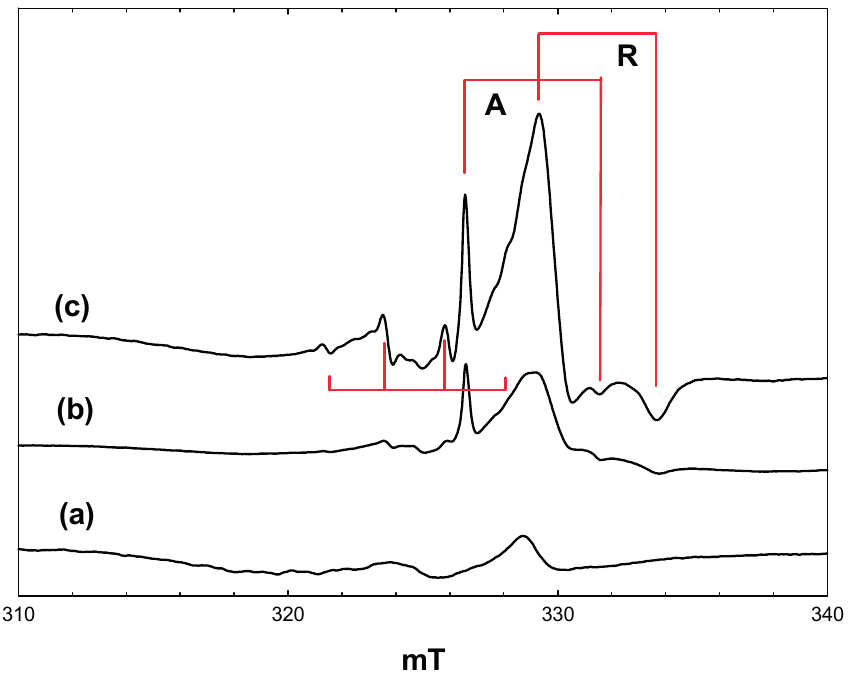
Figure 1. EPR spectra of P25 titania in acetonitrile at 4 K. (a), Prior to irradiation; (b), during irradiation with high intensity broad-band light; (c), after stopping